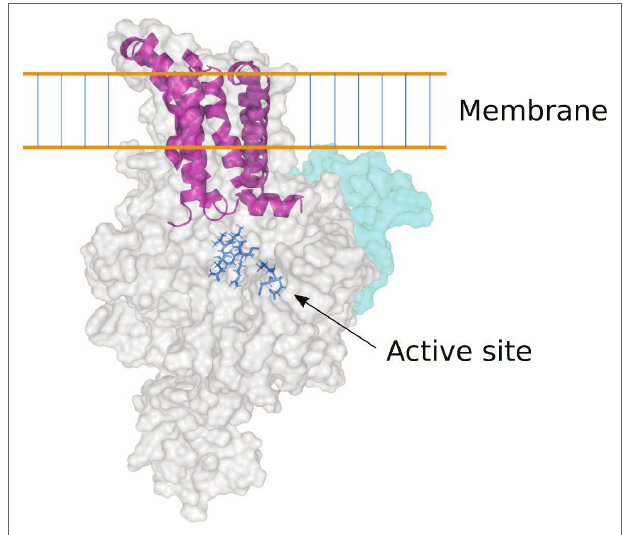
FIGURE 4 | Homology model of the barley CslF6 enzyme. Based on the 3D crystal structure of a bacterial cellulose synthase enzyme (Morgan et al., 2013), this model of the barley CslF6 (1,3;1,4)- β -glucan synthase shows the TED and QVRW active site residues in dark blue stick representation. The nascent (1,3;1,4)- β -glucan chain is extruded through a membrane pore that is formed in the center of six transmembrane α -helices (shown in purple). The pale cyan region of the enzyme shows the modeled position of the insert of approximately 55 amino acid residues that is found only in the CslF6 enzyme. There is some debate as to whether the enzyme is embedded in the plasma membrane or in the Golgi membrane (Kim et al.,